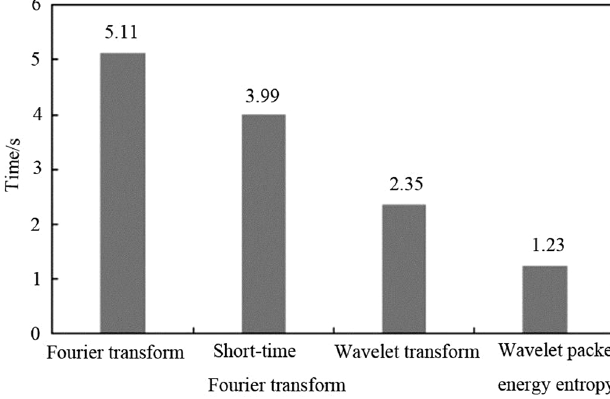
Fig. 9. Recognition precision rate of the fault detection model based on different feature extraction methods. Fig. 10. Recognition time of different feature extraction normal fault